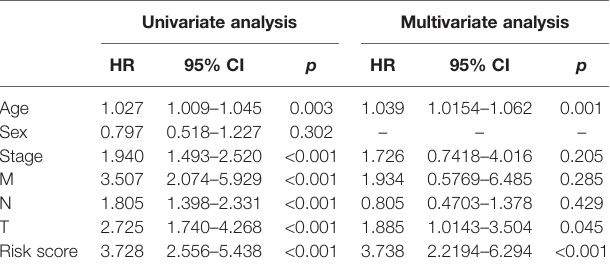
TABLE 3 | Univariate and multivariate analyses of prognostic factors and overall survival of colorectal cancer patients in The Cancer Genome Atlas cohort. Univariate analysis Multivariate analysis